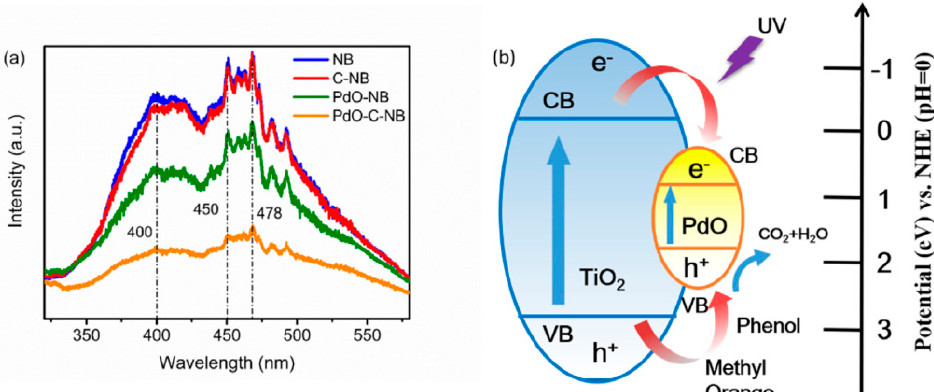
Figure 13. ( a ) PL spectra of photocatalyst samples and ( b ) schematic illustration of energy-band matching in PdO-C-NB for photodegradation of phenol under UV light irradiation [94]. Reproduced with permission from Elsevier, 2022.